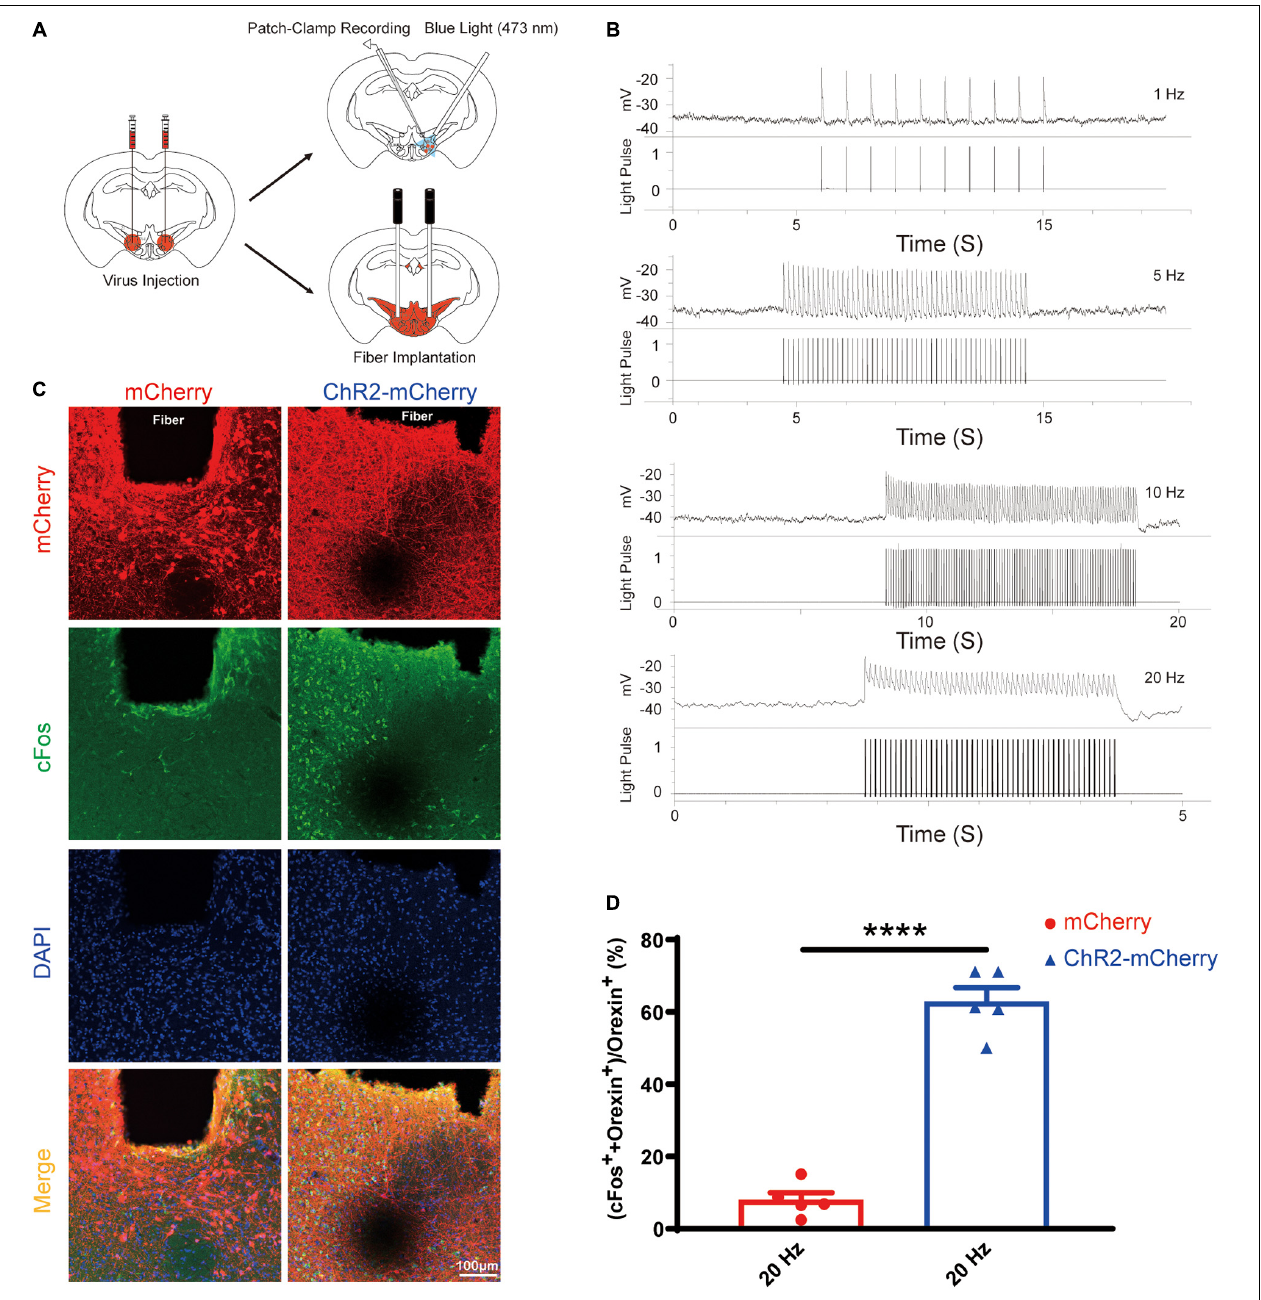
FIGURE 5 | Optogenetic stimulation can reliably excite the orexin neurons expressing ChR2-mCherry. (A) Schematic diagram showing virus injection, patch-clamp recording, and optical fiber implantation. (B) Acute brain slices from mice expressing ChR2-mCherry were used for loose patch recordings. The results showed that orexin neurons expressing ChR2-mCherry can be reliably excited by blue light (473 nm) at different frequencies from 1 to 20 Hz. (C) Slices from mice expressing mCherry or ChR2-mCherry are stained for mCherry (red), cFos (green), and DAPI (blue) in lateral hypothalamus. (D) The statistical comparison of cFos staining in the mCherry group (7.9 ± 2.072, n = 5) vs. the ChR2-mCherry group (62.86 ± 3.923, n = 5), showed the optogenetic stimulation significantly increase the cFos expression in orexin neurons. All data are expressed as mean ± SEM. Significance was analyzed using unpaired t -test between two groups. **** P <